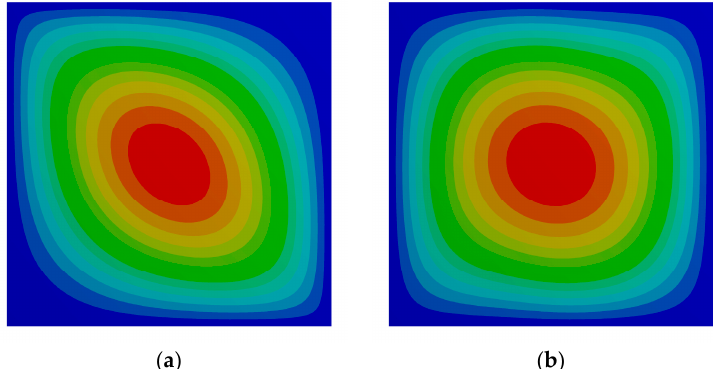
Figure 5. Transverse deflection surface for the optimal layups for the SSSS case. ( a ) constant stiffness (CS) and ( b ) VS. Table 19. Optimum angles for the maximum fundamental frequency [Hz] of a three-layer variable stiffness composite plate.